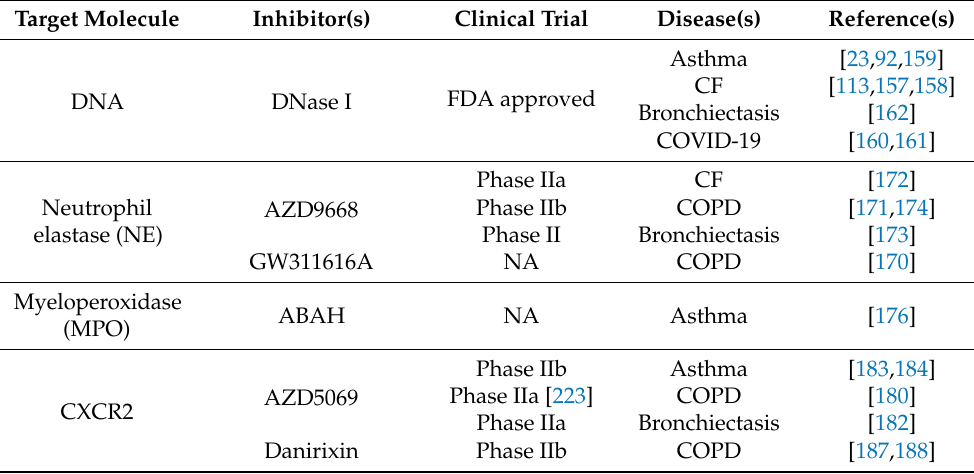
Table 1. An overview of potential targets of neutrophil extracellular traps (NETs) in airway